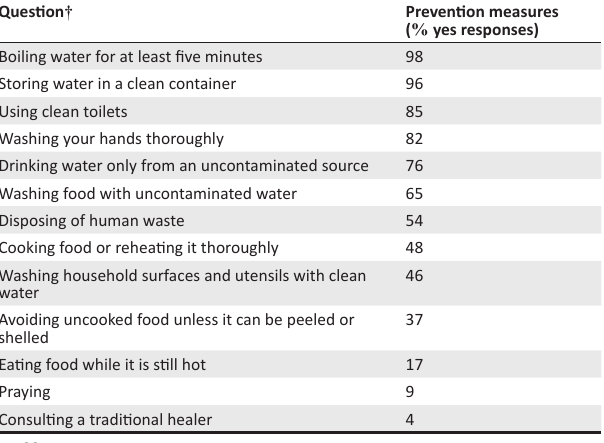
TABLE 4: Respondents’ knowledge on how to prevent contracting cholera.